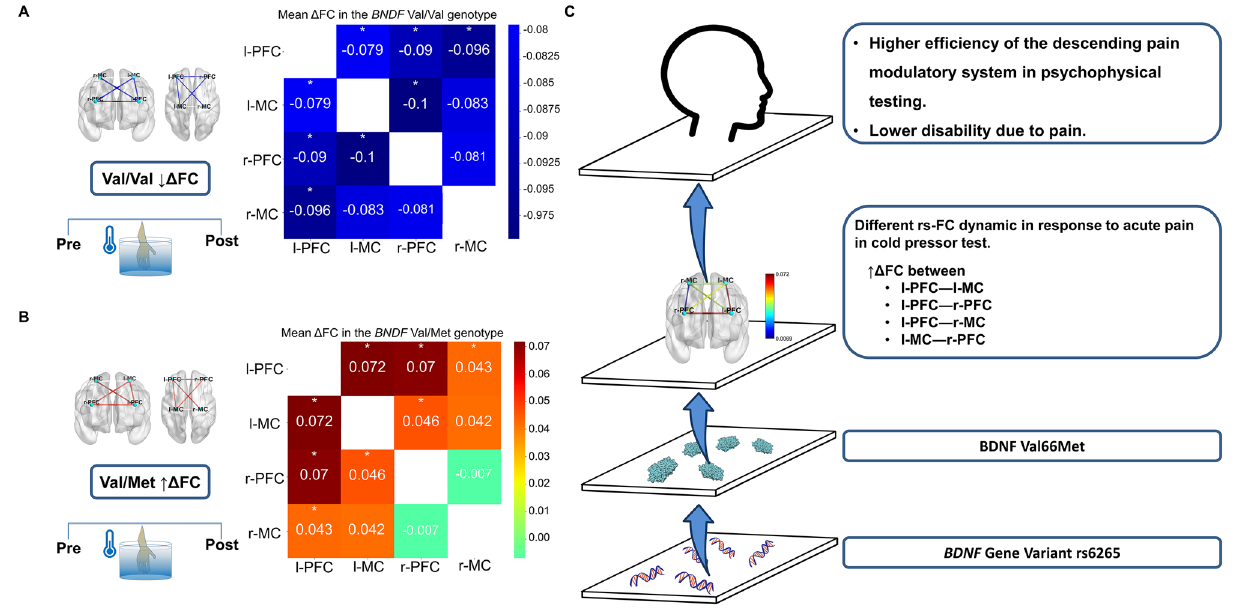
Figure 4. The difference in functional connectivity patterns in response to acute pain according to the BDNF genotype and its associations. The Val66Met (rs6265) polymorphism of the BDNF gene impacts the changes in FC in response to a cold pressor test in female fibromyalgia patients. Heatmaps presenting the difference in 7 min of resting-state functional connectivity assessed after and before a cold pressor test, in the Val/Val and Val/Met groups. The significant differences between groups of BDNF genotypes are presented with an asterisk. ( A ) Data regarding the Val/Val group. The blue edges between regions of interest represent a significant decrease in ΔFC between groups. ( B ) Data regarding the Val/Met group. The red edges represent a significant increase in ΔFC between groups. ( C ) Data associated with the Val/Met group. The Val/Met group presented a significantly ΔFC difference in response to acute pain in the cold pressor test, coupled with lower disability due to pain and performance associated with higher efficiency of the descending pain modulatory system assessed by the conditioned pain modulation test. The colored edges represent ΔFC values as indicated in the heatmap bar. BDNF brain-derived neurotrophic factor. Val/Val Val66Val homozygous. Val/Met Val66Met heterozygous. ΔFC